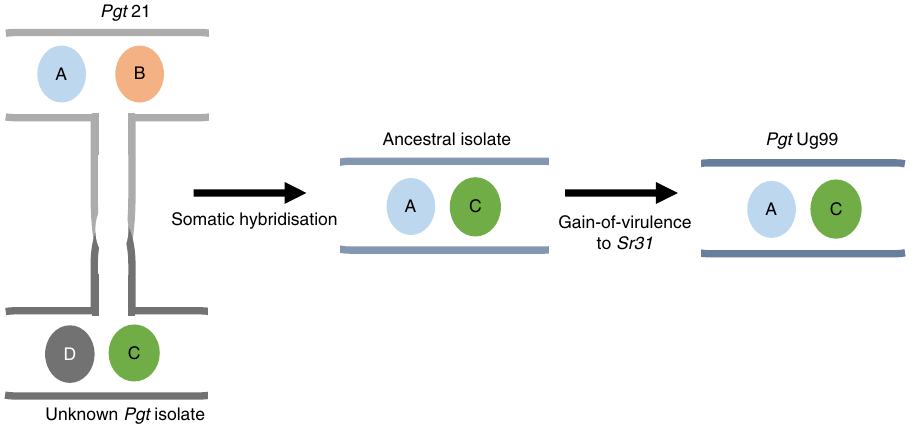
Fig. 7 Model for Ug99 origin by somatic hybridisation and nuclear exchange. The ancestral isolate of the Ug99 lineage acquired the A and C genomes from an isolate of the 21 lineage and an unknown isolate and later gained virulence to wheat cultivars carrying the Sr31